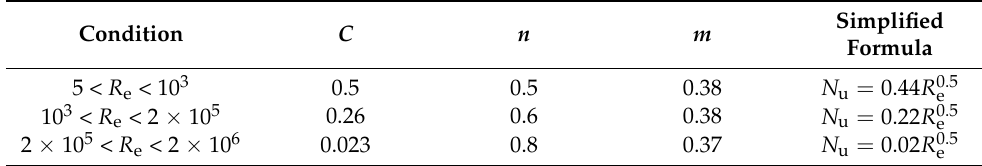
Table 4. C , n and m and their simplified formula.